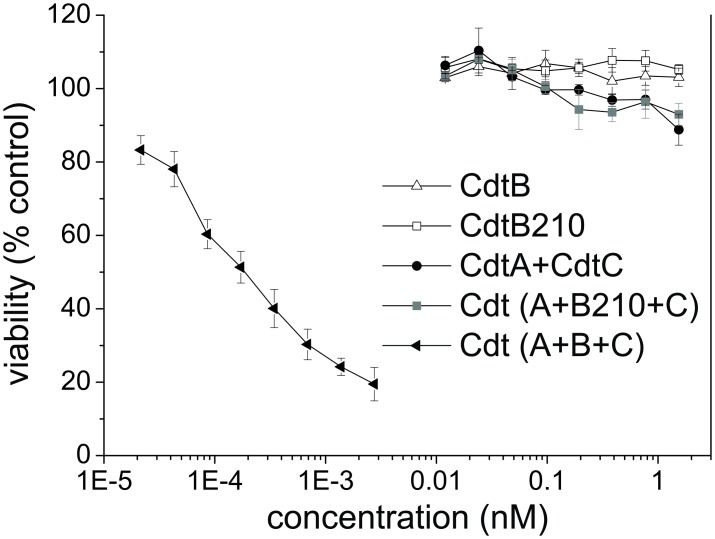
CdtB210 does not intoxicate eukaryotic cells.Cell toxicity assay of equimolar mixtures of the purified CDT subunits (as indicated) in the Jurkat cell line after 48 h incubation as described in Methods. Sub-picomolar toxic effects were only detected for the holotoxin with CdtB. Data are average of two independent experiments presented with standard error, each carried out in duplicate.